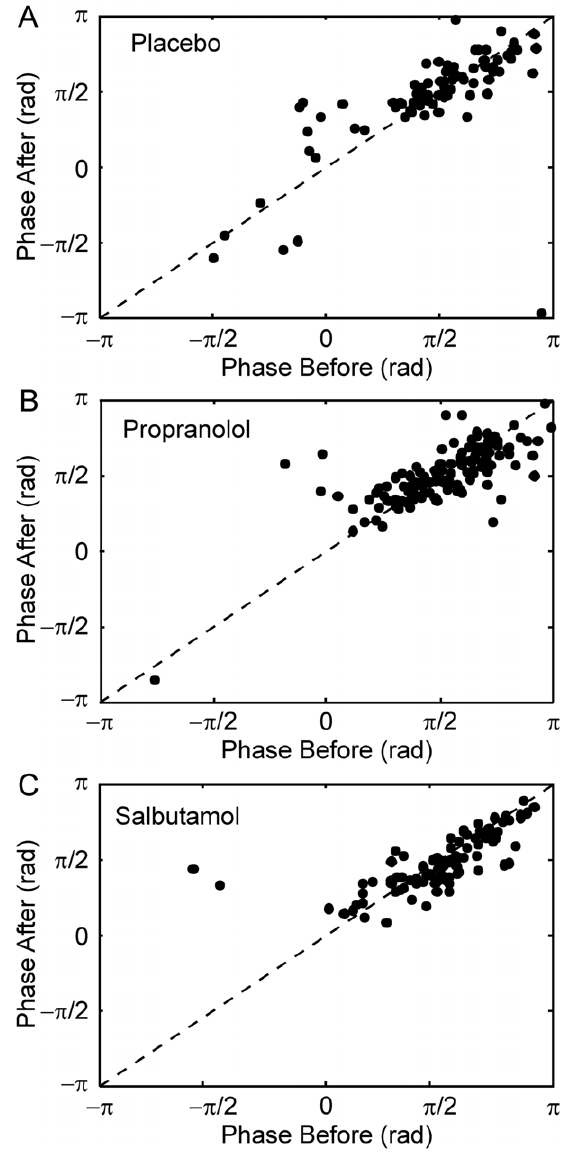
Figure 7. Change in Coherence Phase Following Substance Administration. Each point relates to a frequency bin in the 15.3– 32.2 Hz range in individual muscles and subjects which showed significant coherence both before and after substance administration. The phase after the drug is plotted against the phase before. A, placebo, B, propranolol C, salbutamol. Dashed line indicates identity. Note that in (C) the majority of points lie below the line of identity.